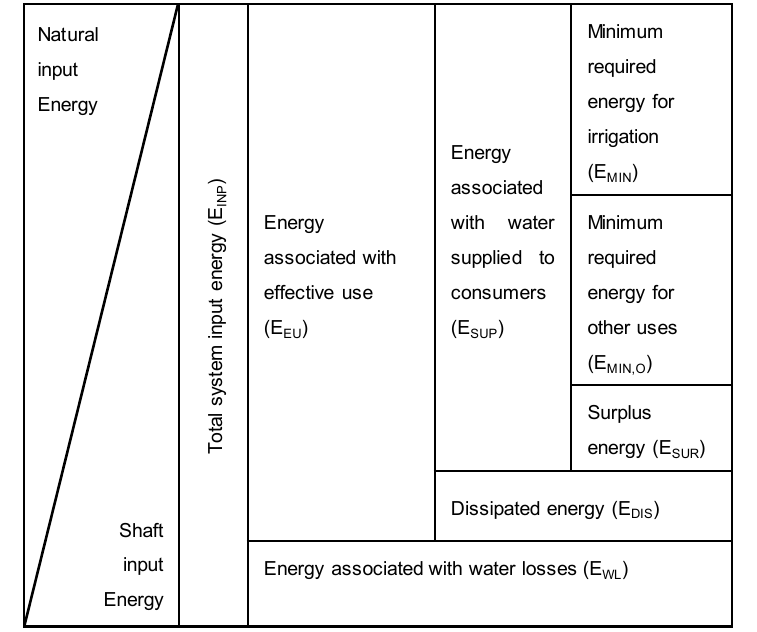
Figure 2. Proposed water–energy balance for urban green spaces (kWh/year).